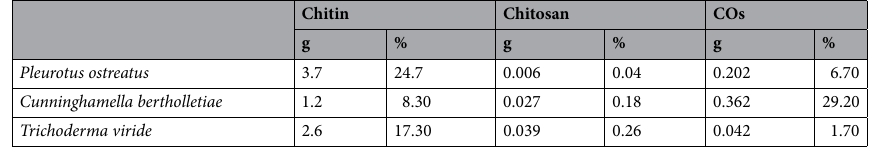
Table 1. Chitin, chitosan and CO yield from each of the three fungi. Yields are expressed as both dry mass (g) and percentage values (%) of the starting fungal dry biomass (for chitin and chitosan) or the starting chitin amount (for